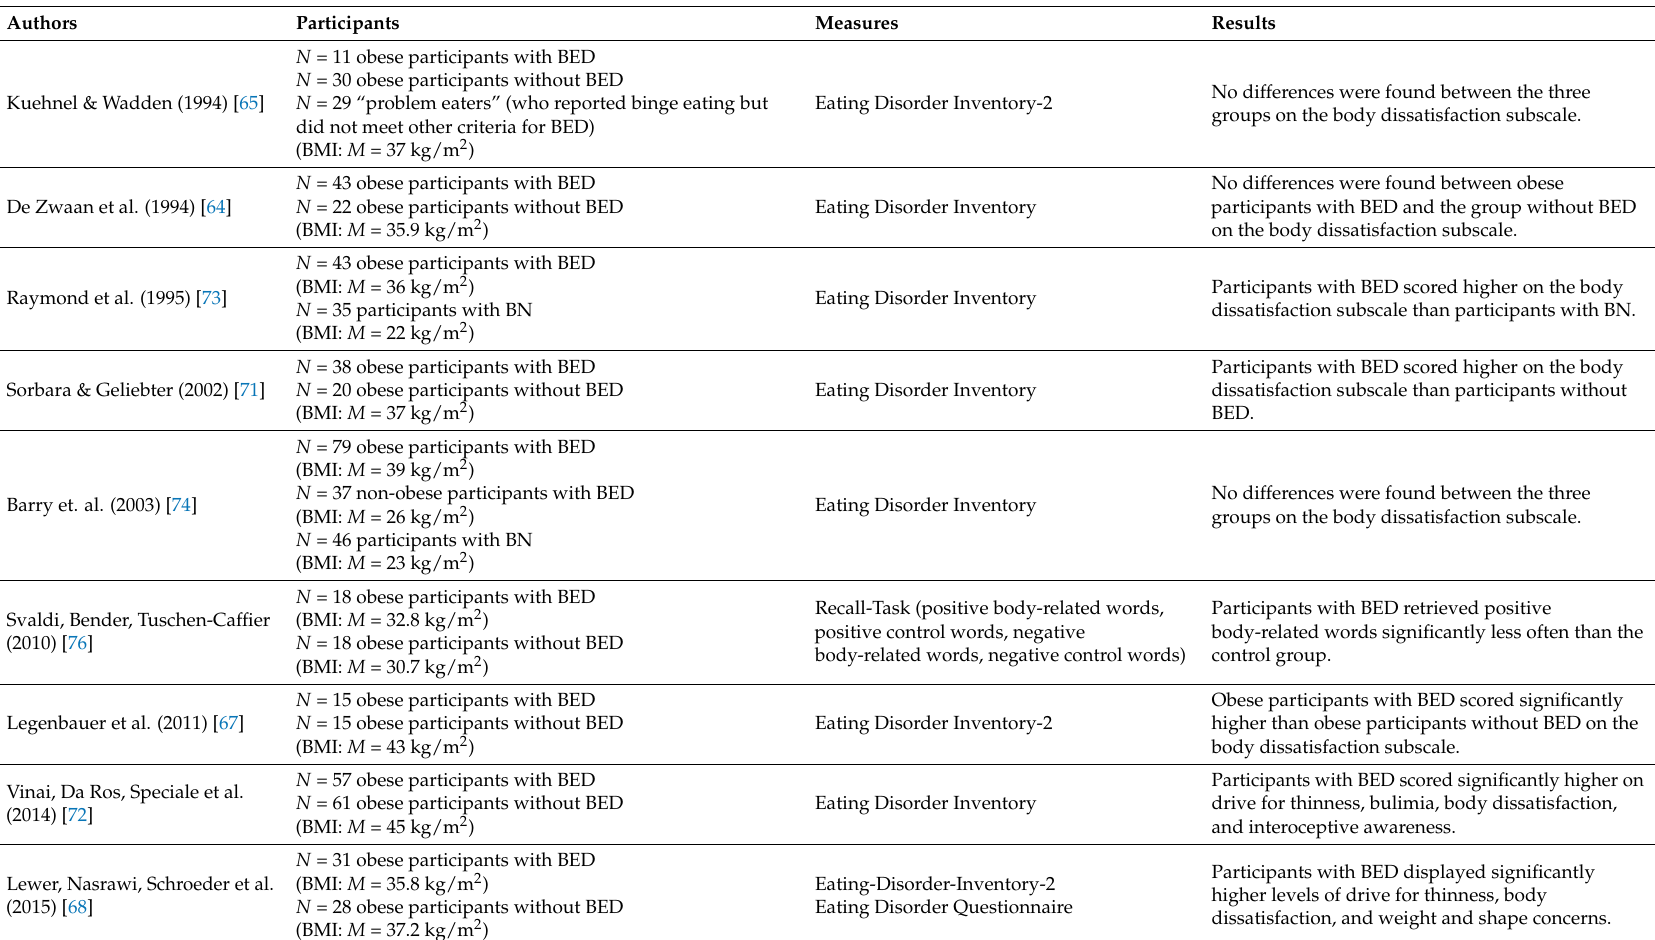
Table 1. Studies of body